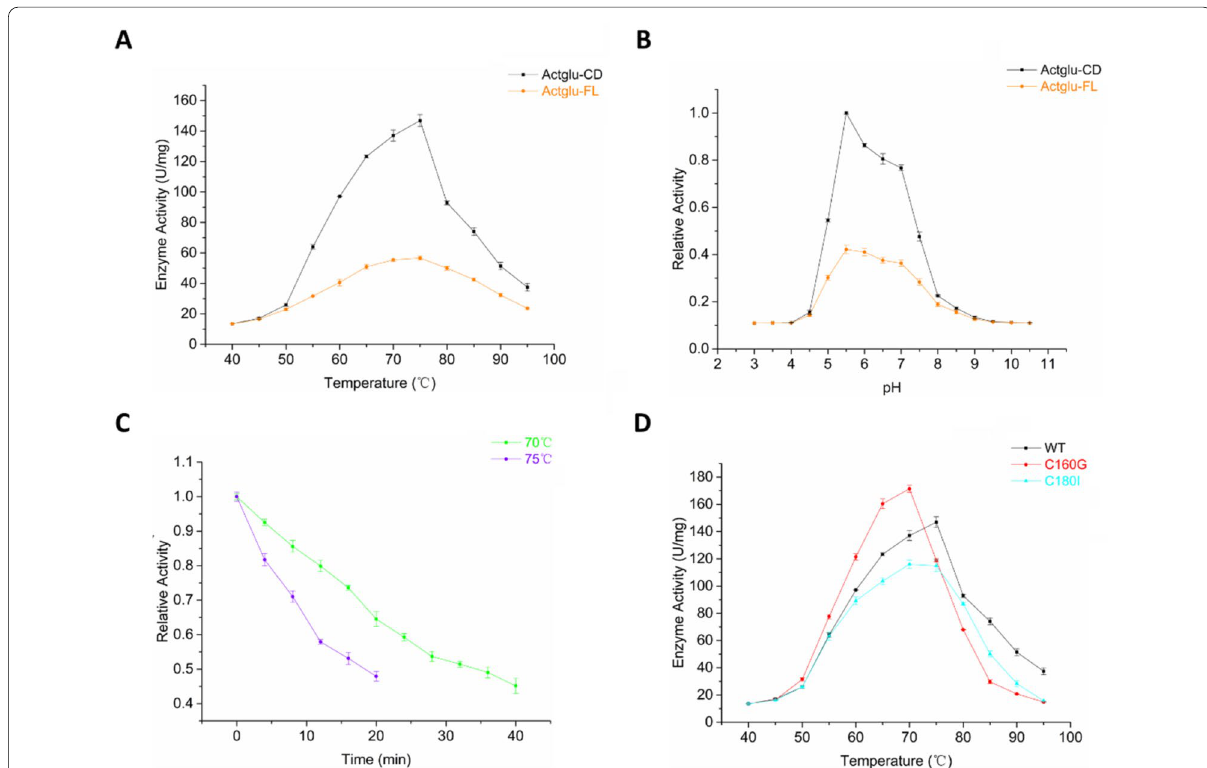
Fig. 3 The activity and thermal stability of β-1,3-glucanase. A the temperature profile; B the pH profile; C the thermal stability of Actglu-CD at 70 and 75 °C, respectively. D activity comparison among Actglu-CD and its mutants (C160G and